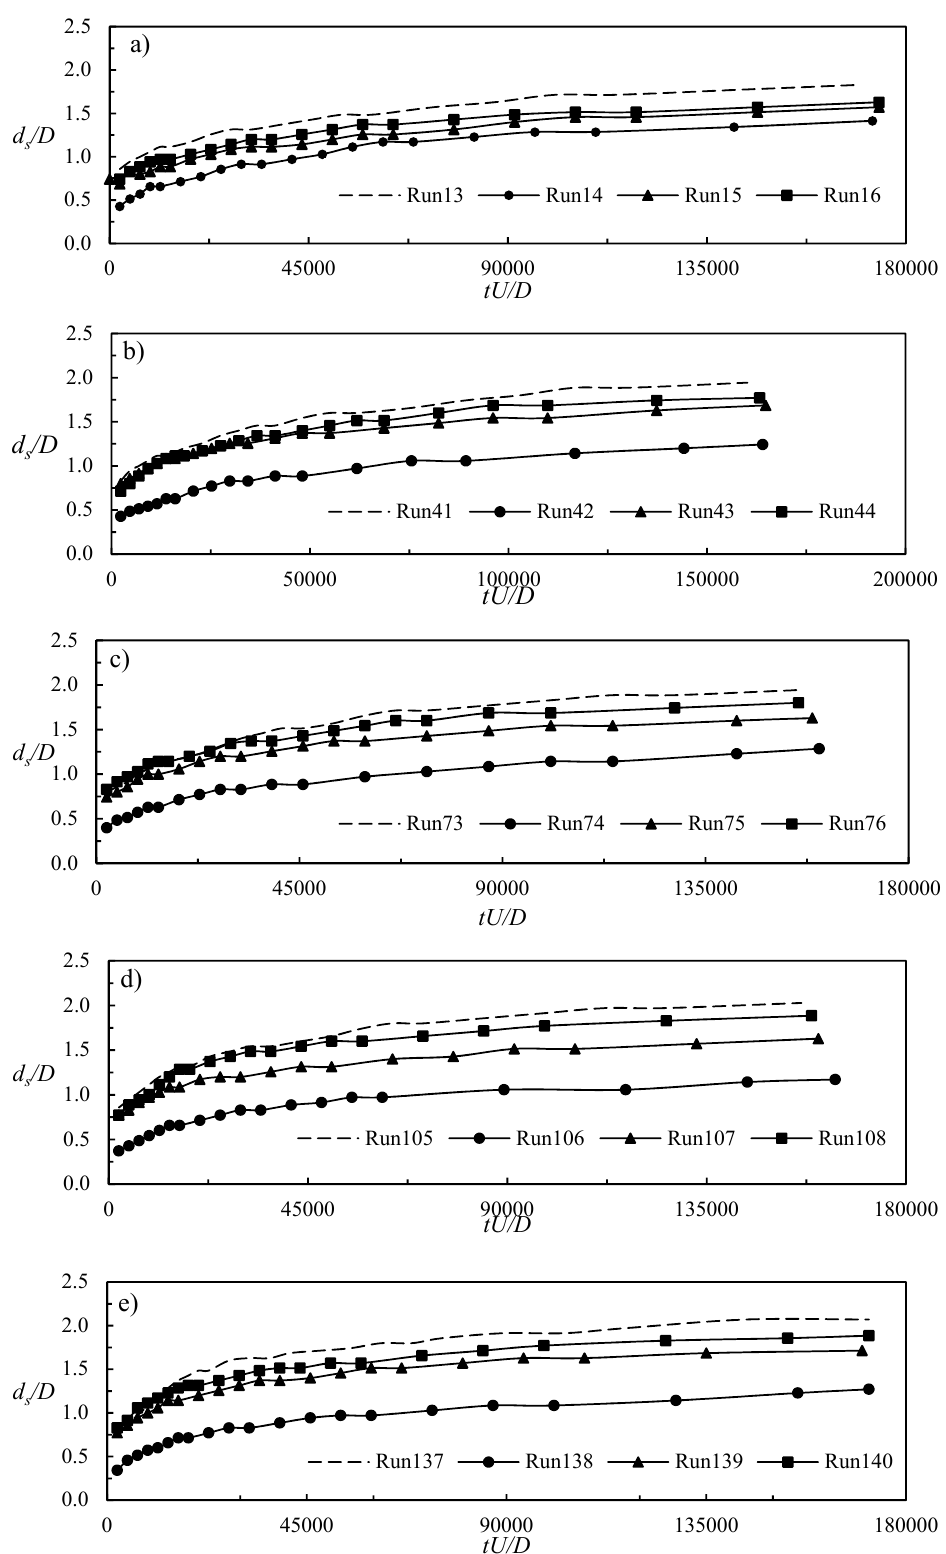
Figure 7. Temporal development of the maximum scour depth for ( a ) Z / D = 0, ( b ) Z / D = 1, ( c ) Z / D = 2, ( d ) Z / D = 3, and ( e ) Z / D = 4. In each plot, the first run is for no sill and the others are ordered as X s / L pc = 0, 0.5, and 1.